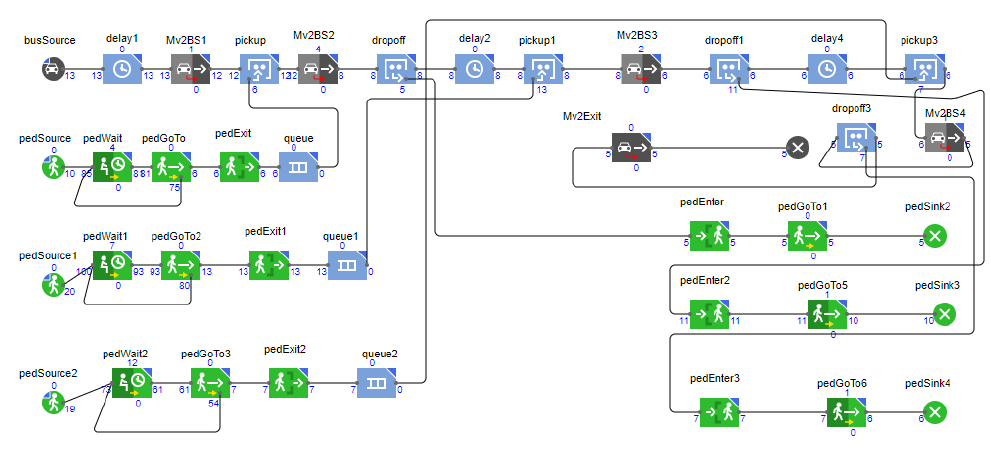
Figure 6. Work-flow of Model for BRTS.